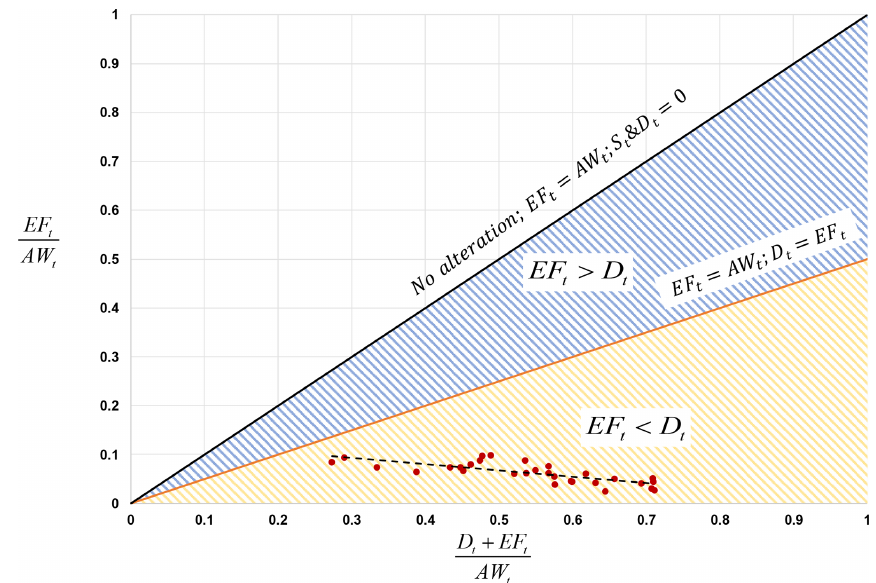
Figure 5. Modeling synthesizing flow alteration in the Budyko supply and demand framework: the ratio of environmental flow (“actual”; EF t ) and the available water (AW t ) as a function of the ratio of the total demand for human and environmental flow (“demand”; D t ) and the available water (“supply”). Annual flows from Falls Lake, North Carolina (red dots), show human withdrawal for water supply is more than the downstream environmental flow